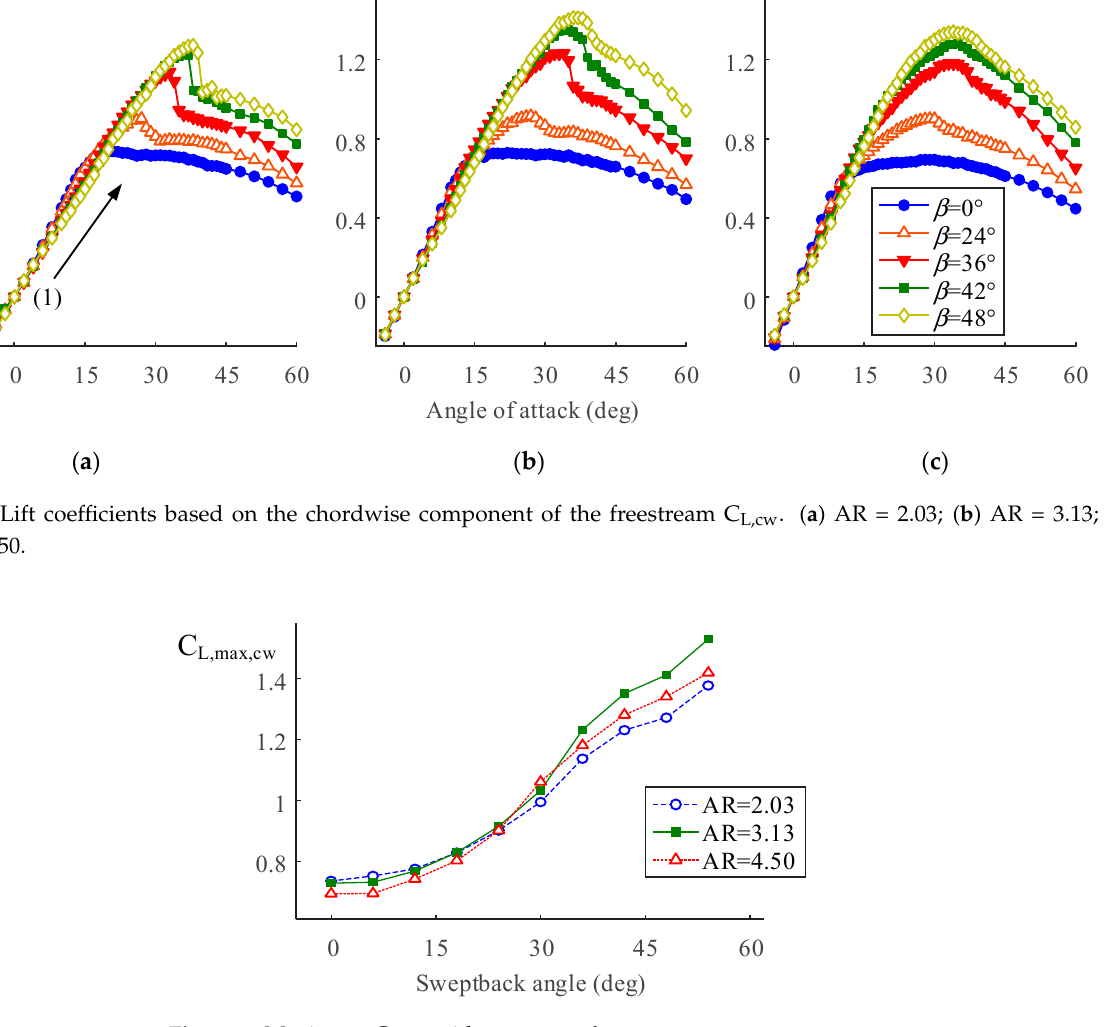
Figure 8. Maximum C L,cw with respect to β .